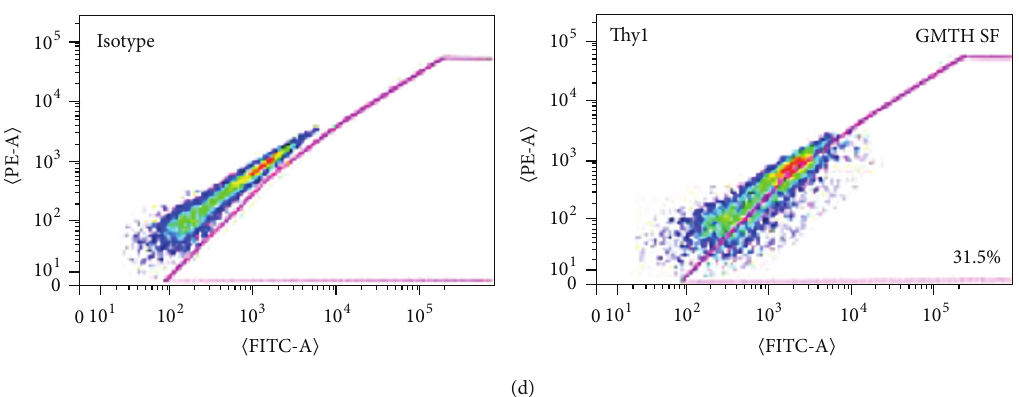
Figure 4: Expression of cardiac and fibroblast markers in ciCLMs. (a) Examples of intracellular FACS analysis for the isolation of Tnnt2+ cells (green)andisotypecontrols(red)inciCLMsafter14daysofdifferentiation.(b)ExampleofWesternblotanalysisafter14daysofdifferentiation showed the presence of cardiac troponin I as a late cardiac marker protein in ciCLMs derived from both GHMT CF and GHMT SF cells. Densitometry quantification performed with ImageJ software showed that Tnni3 was 3,2-fold more expressed in GHMT CF compared to GTMH SF. Troponin I was absent in CF and SF transduced with 𝛼 -MHC-GFP vector. (c) Expression of the fibroblast marker HSP47, in transduced cells compared to control cells (transduced with only 𝛼 -MHC-GFP vector). HSP47 expression strongly decreases in ciCLMs after 7 and 14 days of differentiation compared to the controls; 𝑛 = 5 , 2-way ANOVA test, ∗ 𝑝 < 0.01 . (d) Examples of FACS analysis on ciCLMs confirmed a reduced number of Thy1 (CD90) + cells after 7 days of